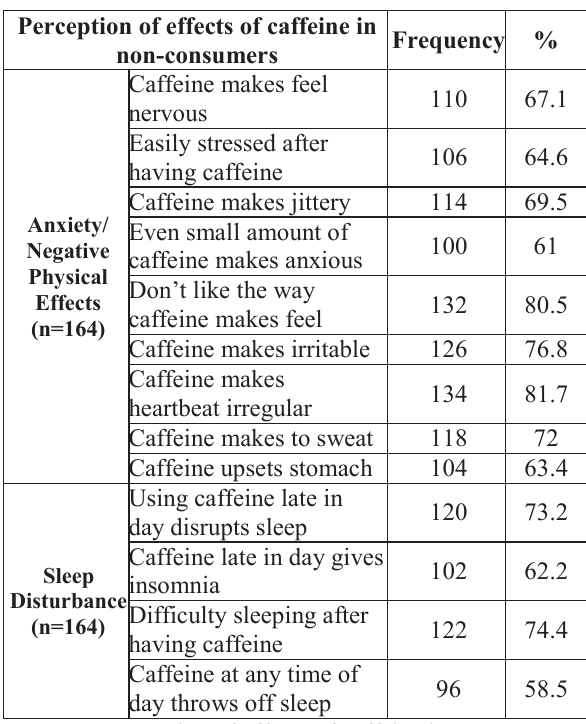
Table-3: Perception of effects of caffeine in non-